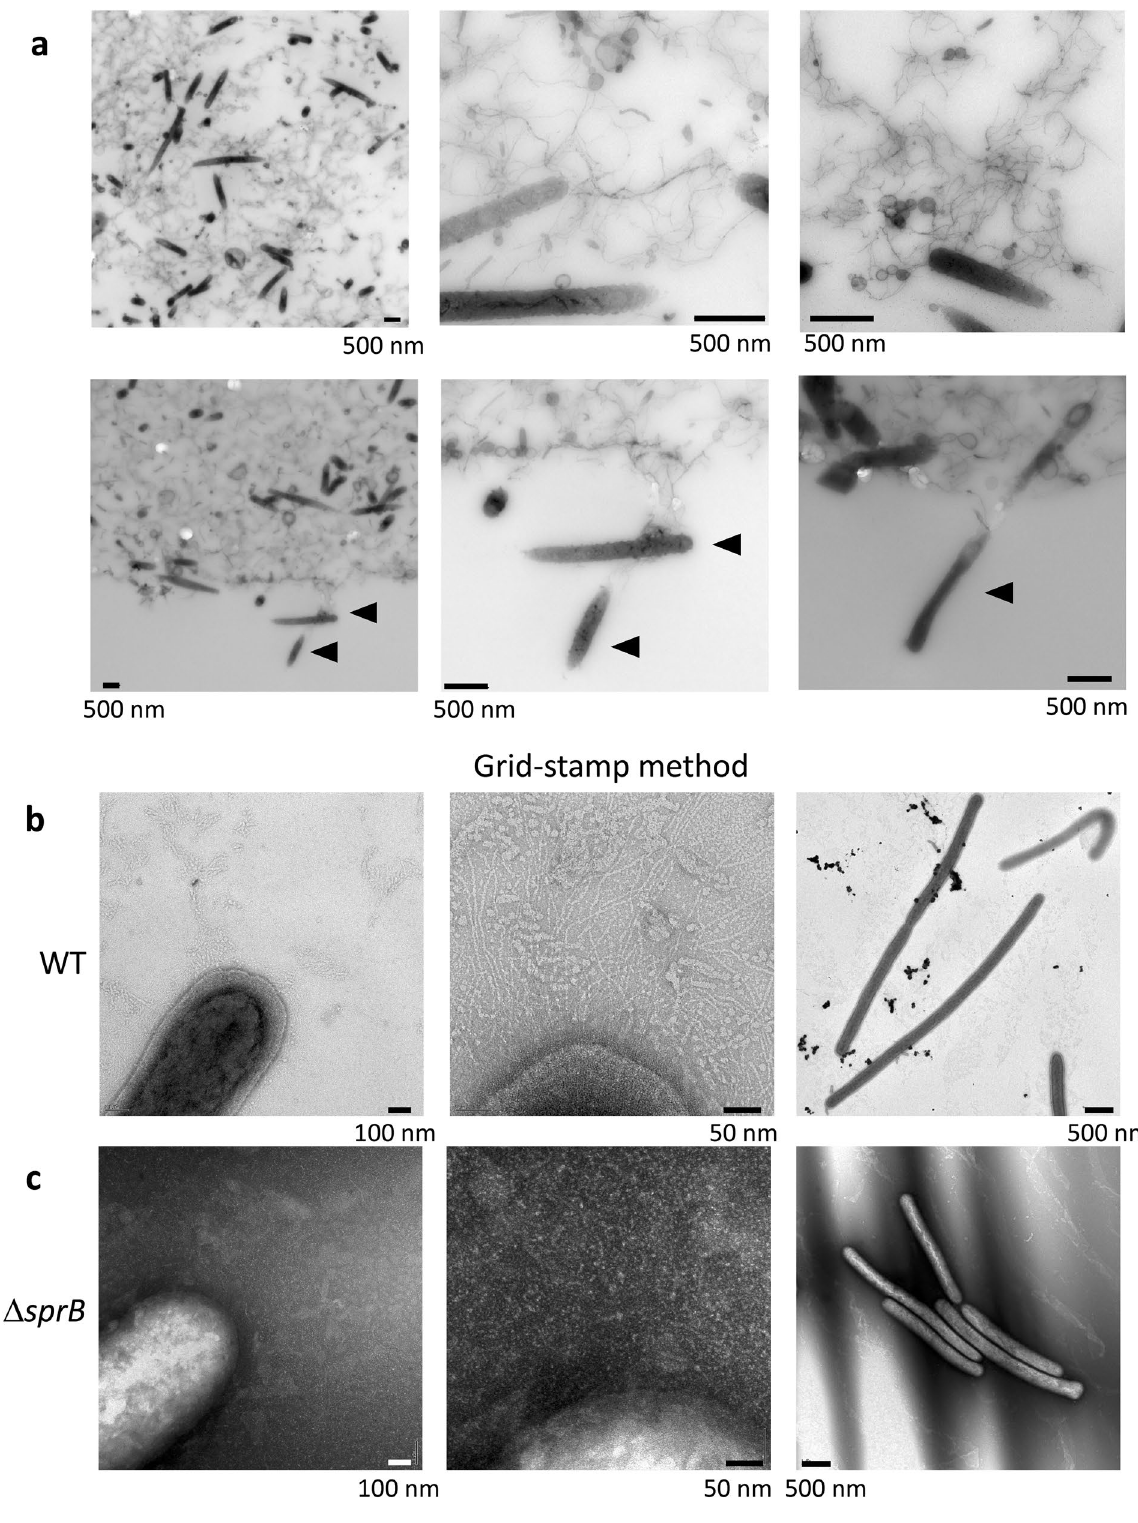
Figure 4. Higher magnification images of the spreading colonies shown in Fig. 3. ( a ) TEM image of a 400 nm-thick, unstained, Epon section of a WT colony spreading on 0.3% A-PYG (15 mM). The space between bacterial cells is occupied by fibers and vesicles (upper panels). Migration of bacterial cells into the 0.3% agar layer (lower panels). WT cells metastasize into the agar medium (arrowhead). ( b,c ) Grid-stamp images of the spreading front region of WT ( b ) and Δ sprB ( c )